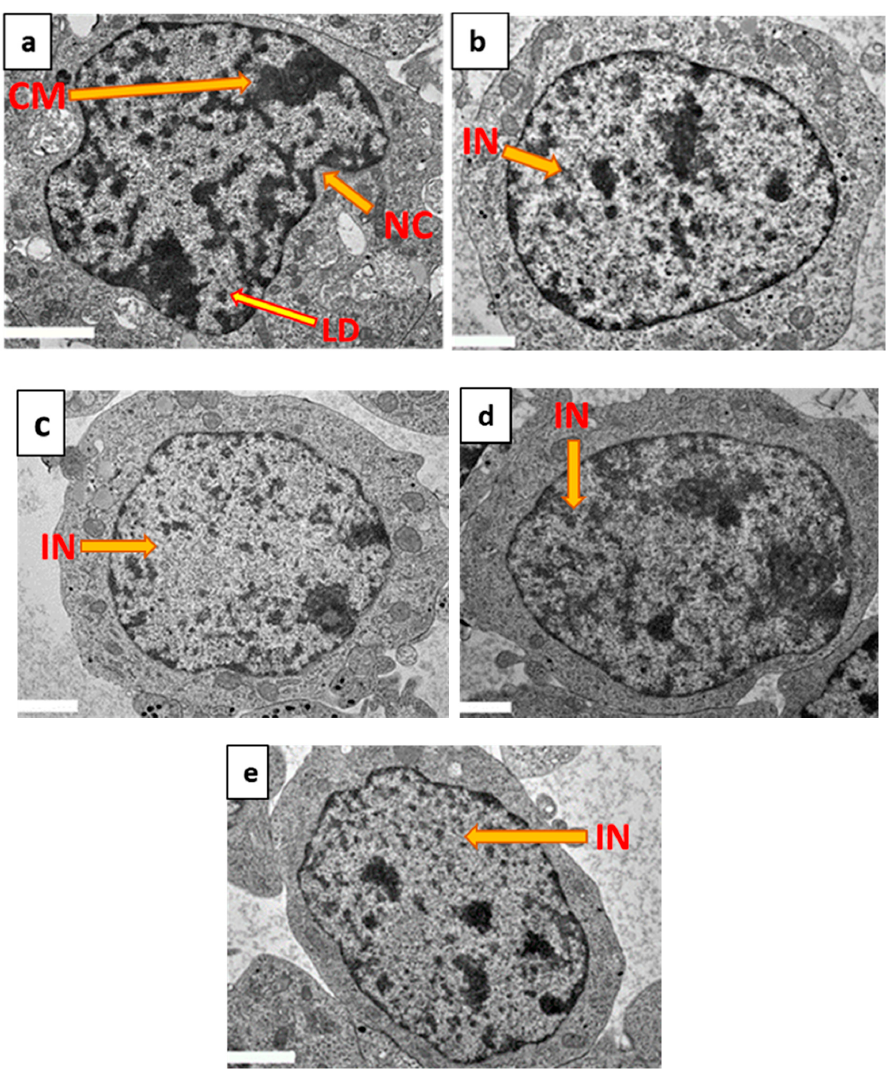
Figure 9. Ultrastructural assessment of di ff erentiated SH-SY5Y cells by TEM. ( a ) Cells exposed to H 2 O 2 for 4 h. ( b ) Untreated cells. ( c ) Cells pretreated for 72 h with 2.08 µ M